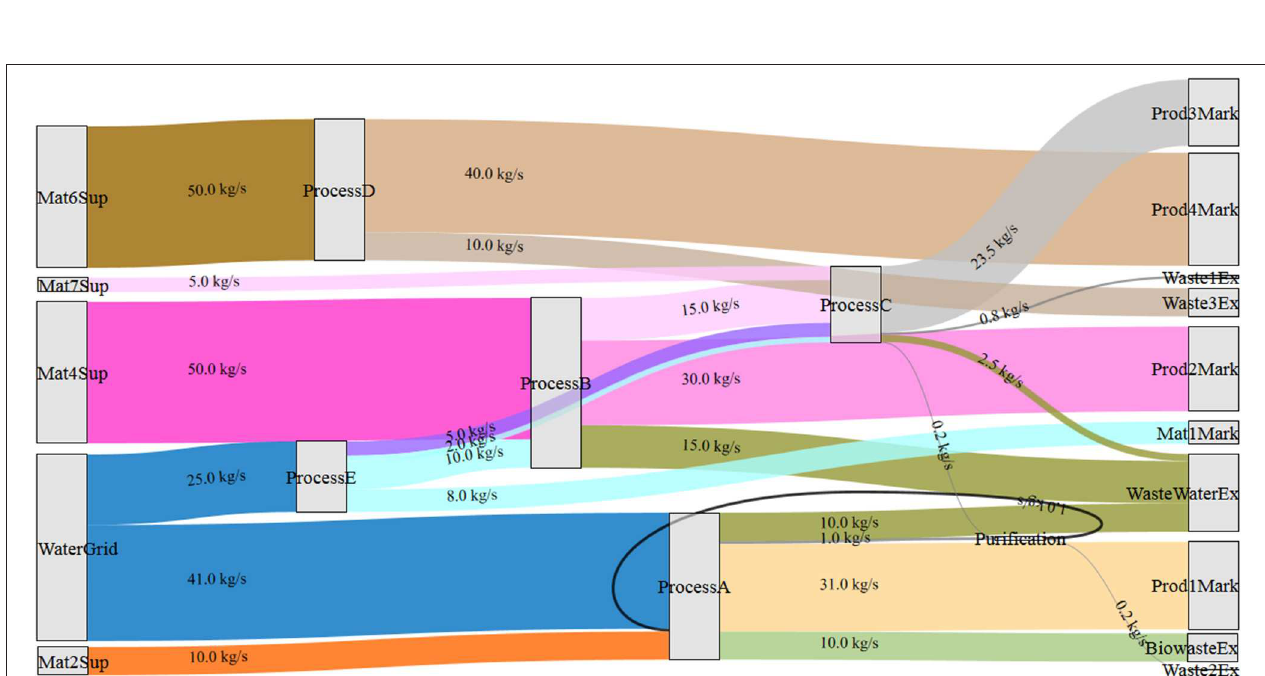
FIGURE 8 | Sankey diagram showing the resulting flows for total cost